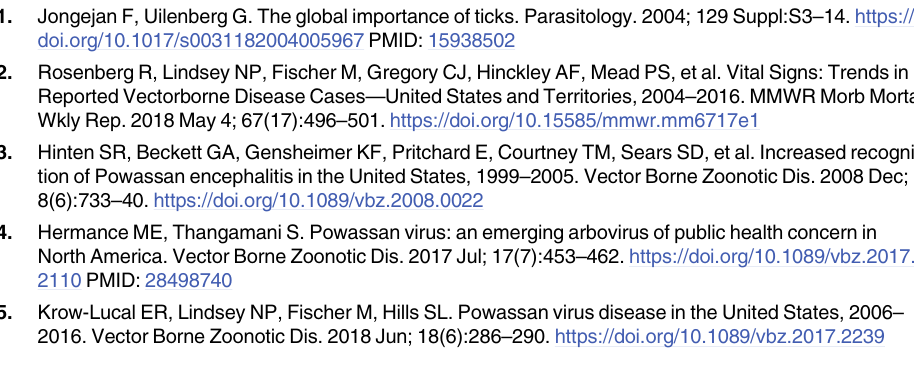
S3 Table. Statistical significance of mean clinical disease score when the control group is compared to an infection dose. Statistically significant differences in mean clinical disease scores were compared by a one-way ANOVA followed by Dunnett’s multiple comparisons test to compare the infection doses to the control